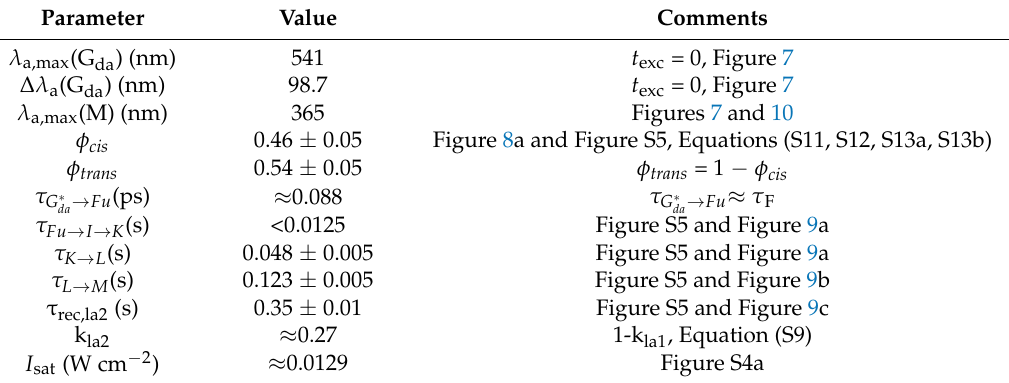
Table 2. Primary retinal photocycle dynamics of CaRh in pH 7.3 HEPES/MOPS buffer (G da → I → K → L → M → G da ). Photo-excitation with LED 590 nm.